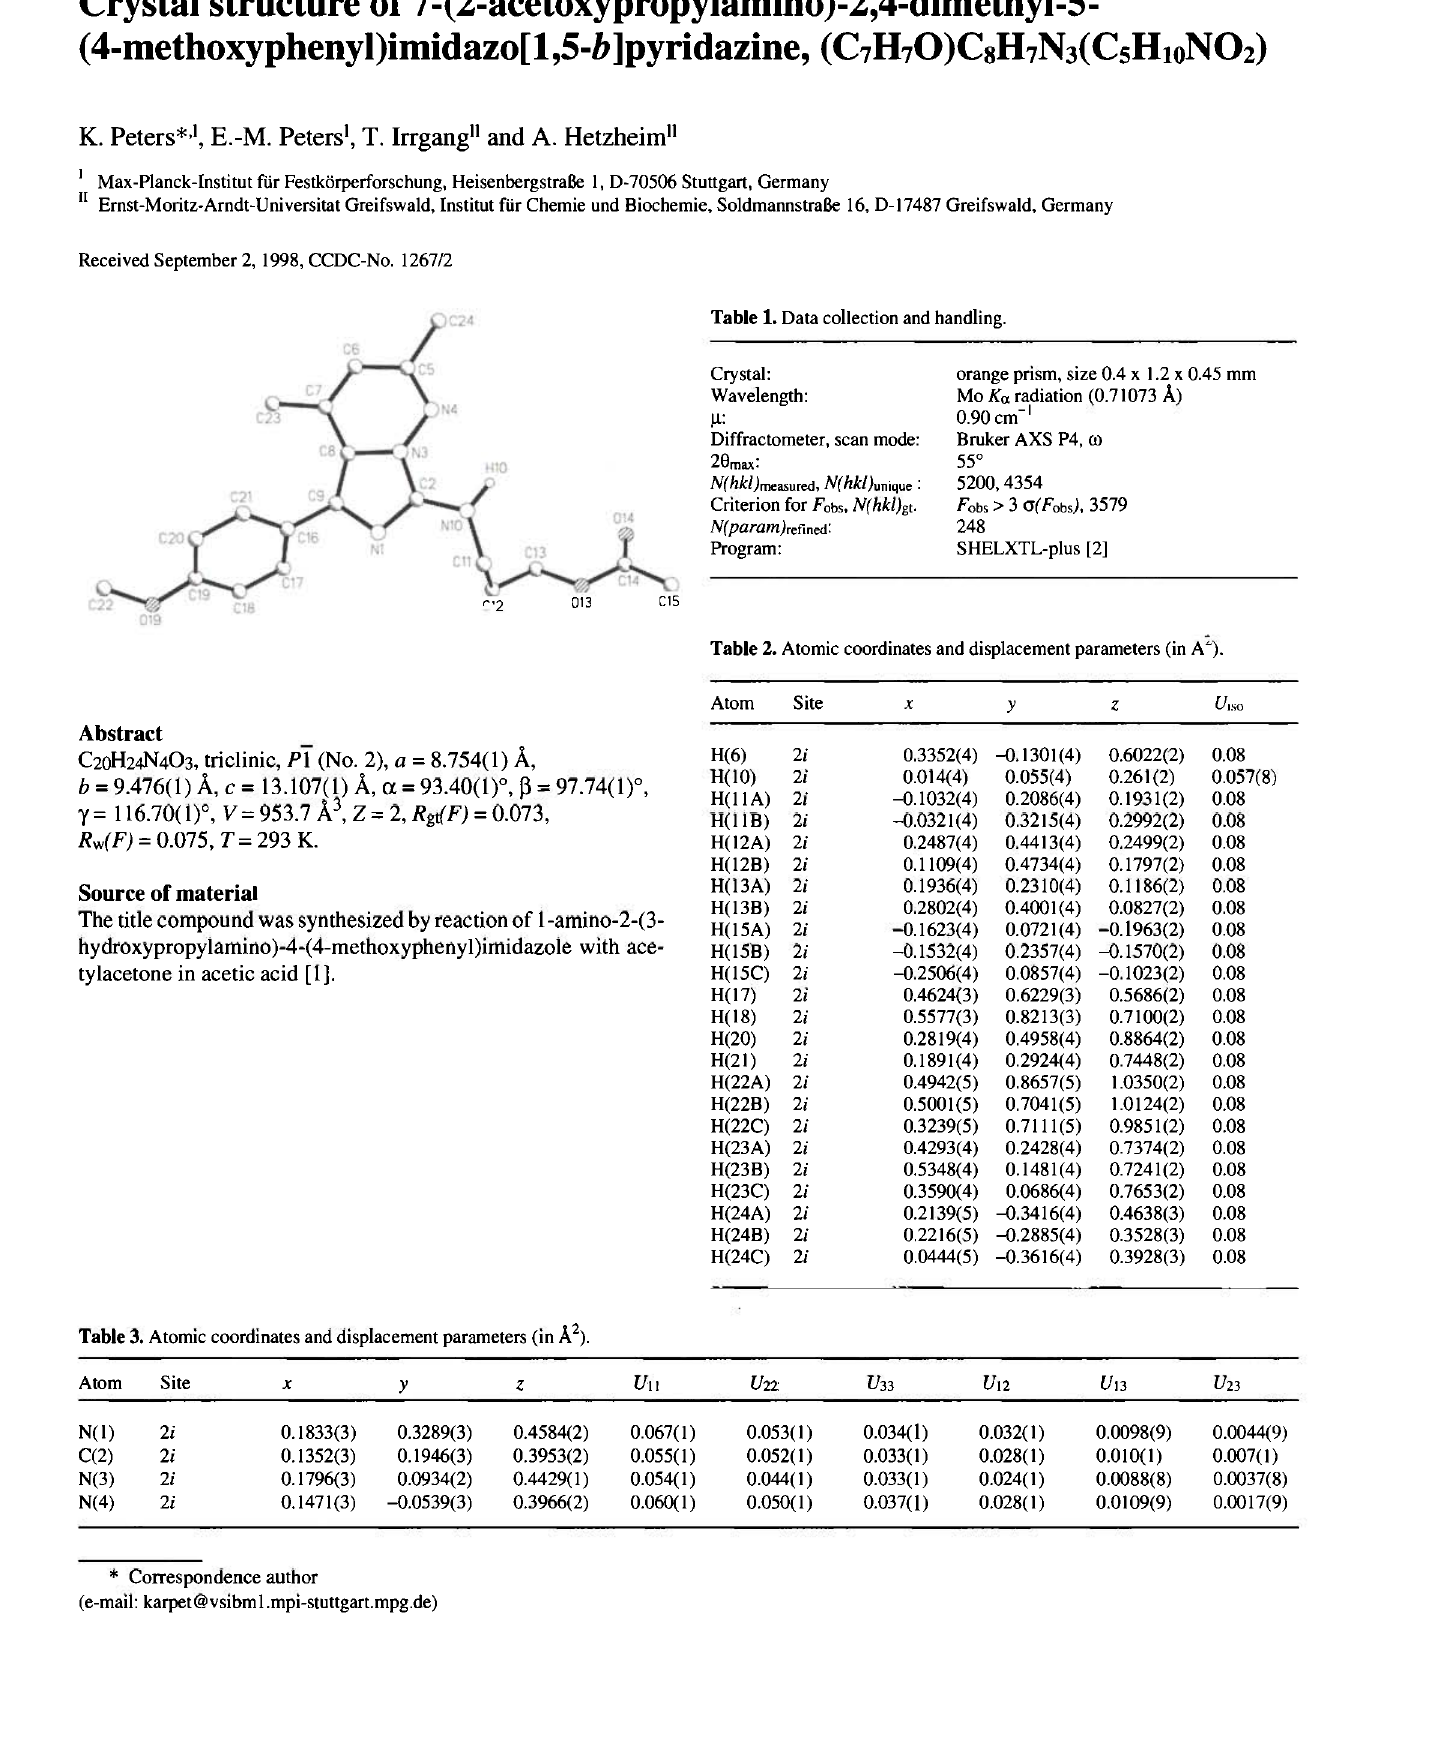
Table 1. Data collection and handling.